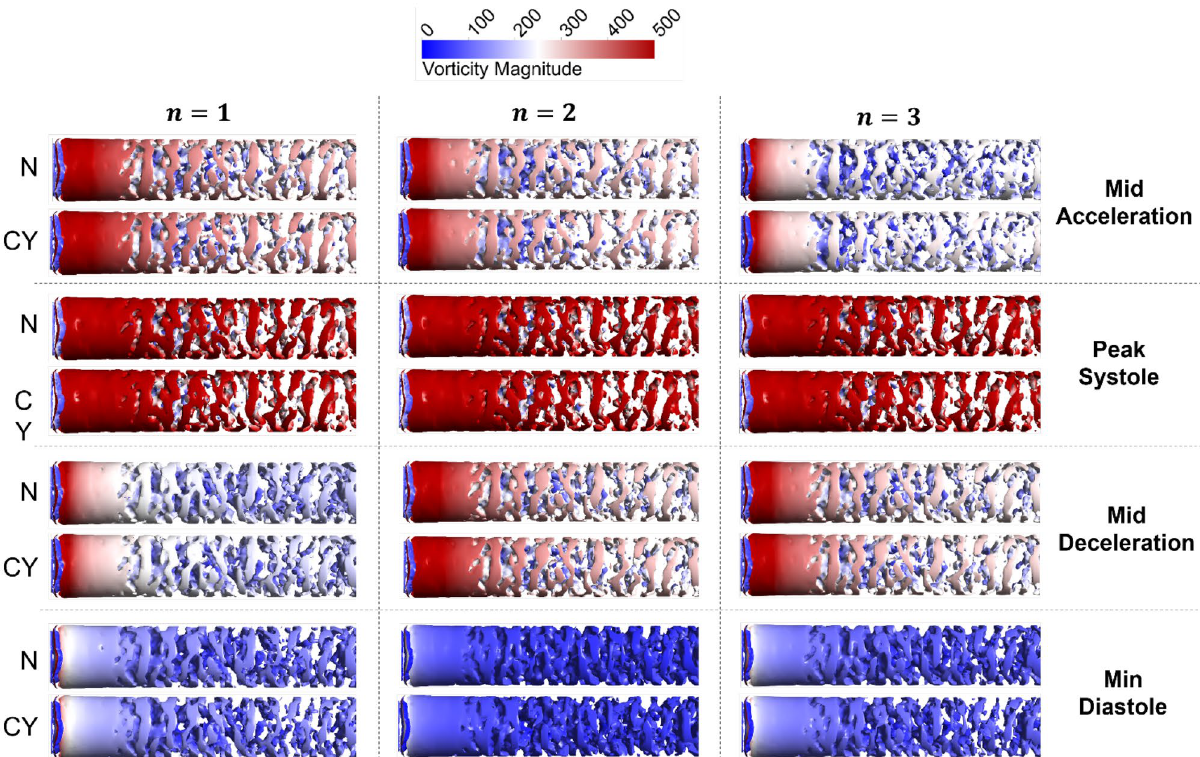
Figure 5. Iso-volumes of Q-criterion coloured by vorticity magnitude at ( 0 < Q ≤ 0.02, 0 ≤ � ζ � ≤ 500 ) for different harmonics ( n =1,2,3, columns) at different time instances of the cardiac cycle (rows, right) for Newtonian and non-Newtonian viscosity (N and CY, rows,